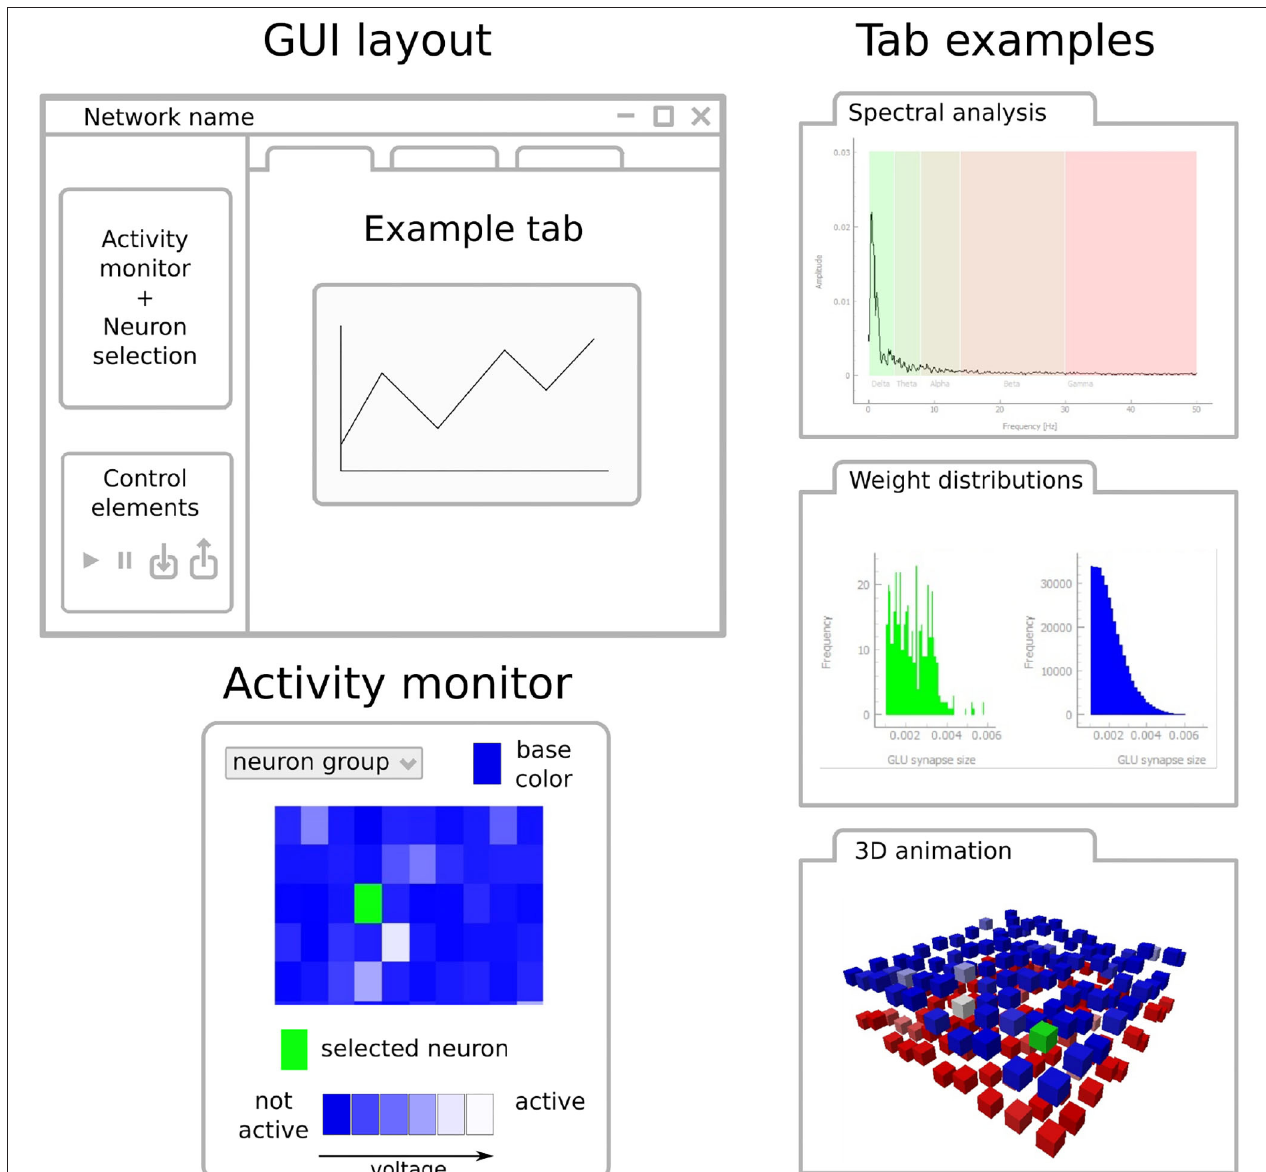
FIGURE 3 | Design elements of PymoNNto’s graphical user interface. The GUI layout is structured as follows: The left bar contains an activity monitor and control elements. The activity monitor displays one or several neuron groups in real time. Each neuron group can receive a distinctive base color. In addition, one can select one or several overlay colors to display ongoing activity, reflecting for example the current voltage or spikes. The activity monitor allows to select individual neurons (green) for further analysis. Control elements allow for example to start, pause, save, and load the simulation and can contain additional tab-specific elements. PymoNNto’s GUI contains a large variety of tabs which can be used to analyze and monitor network properties. Three exemplary tabs are shown on the right: Spectral analysis of membrane potentials (top) , histograms of synaptic weight distributions (center) , and a three-dimensional animation of network activity with excitatory neurons in blue, inhibitory neurons in red (bottom) , recently active neurons in white, and a selected neuron in green. For a real GUI example, see Figure 6